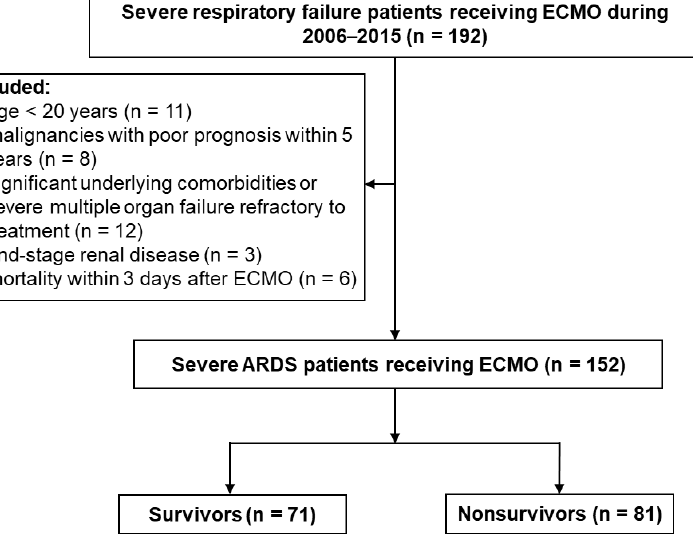
Figure 1. Flowchart of enrolling patients with severe ARDS with ECMO support. ARDS, acute respiratory distress syndrome; ECMO, extracorporeal membrane oxygenation.